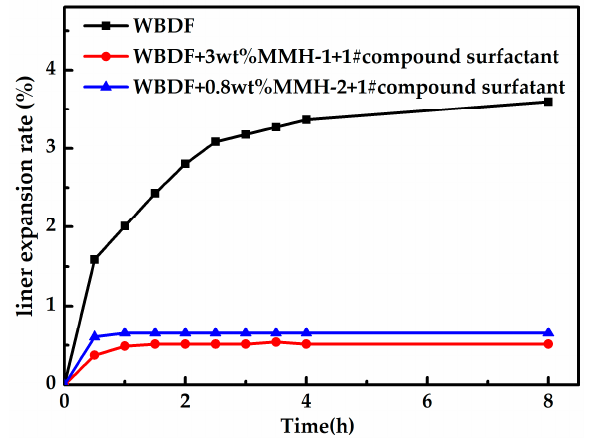
Figure 11. Effect of various drilling fluid on liner expansion rate of the Longtan coal.